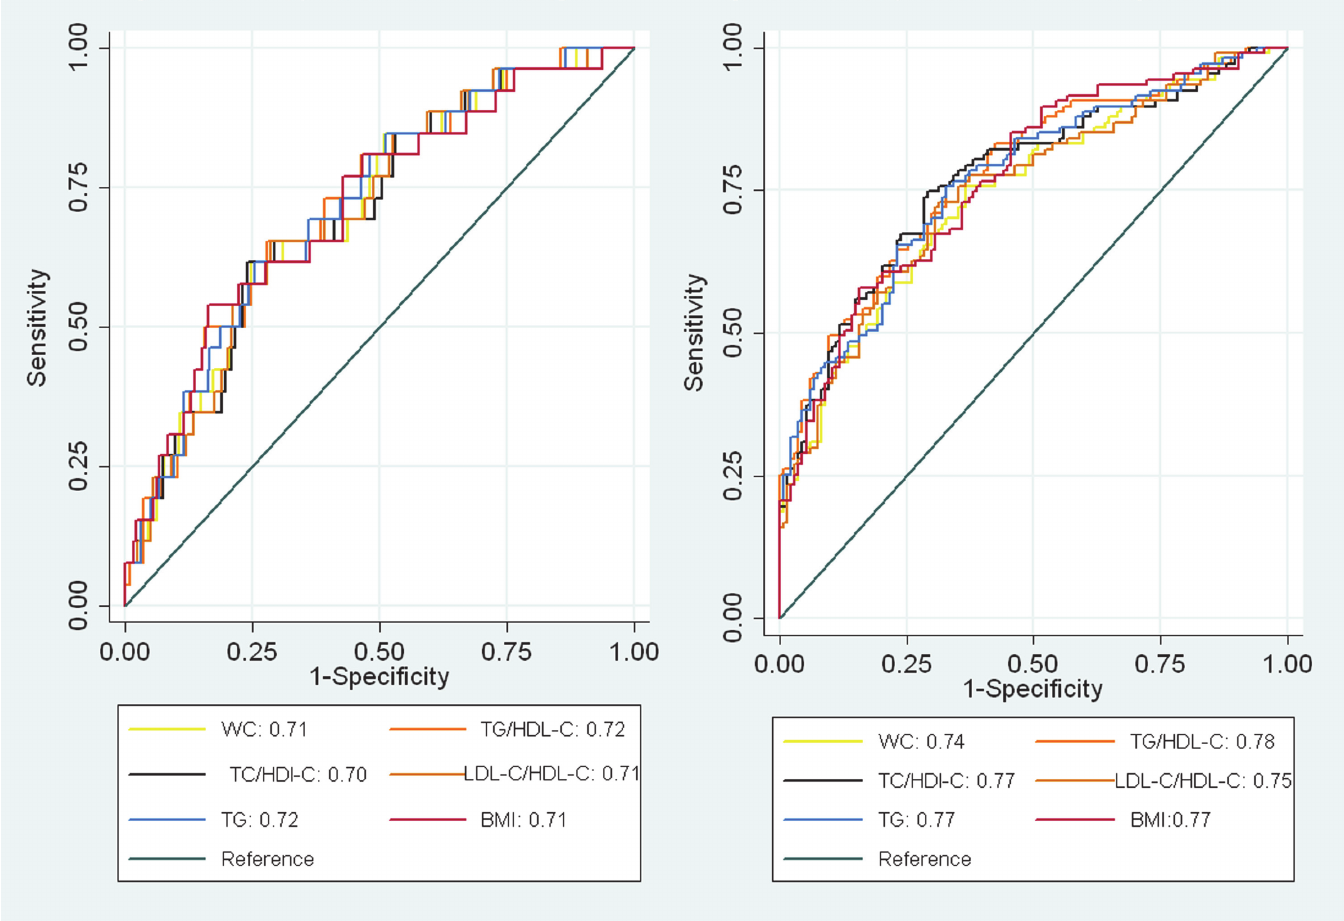
Figure 1. a. AUROC curves for potential markers of HOMA-IR in normal-weight men. b. AUROC curves for potential markers of HOMA-IR in overweight/obese